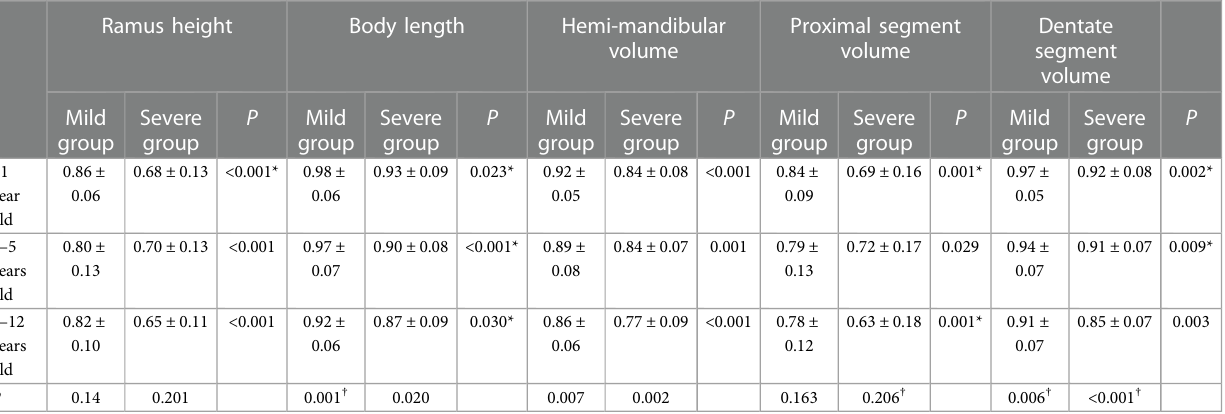
TABLE 3 Comparisons of A/C ratio in different age